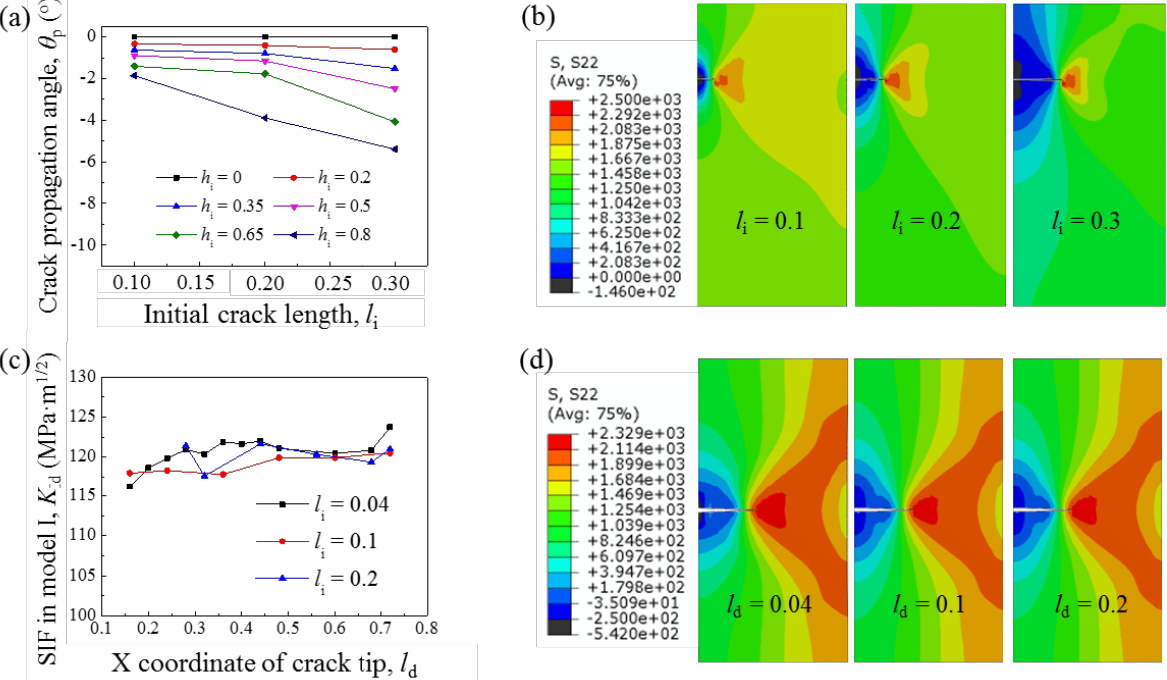
Figure 8. Comparison of ( a ) crack propagation angles when the initial crack lengths range from 0.1 to 0.3 and ( b ) stress contours with initial crack length 0.3; Comparison of ( c ) K Id and ( d ) stress contours when the initial crack lengths range from 0.04 to 0.2 at 0 crack location.